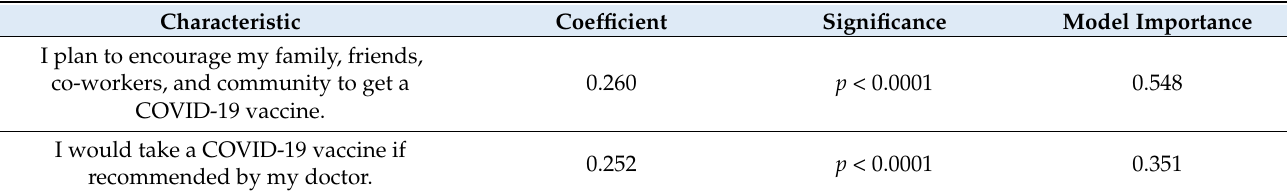
Table 2. Characteristics and beliefs associated with the intention to receive a COVID-19 vaccine. LINEAR modeling of 31 demographic and attitude variables in 205 people prior to participating in a webinar.